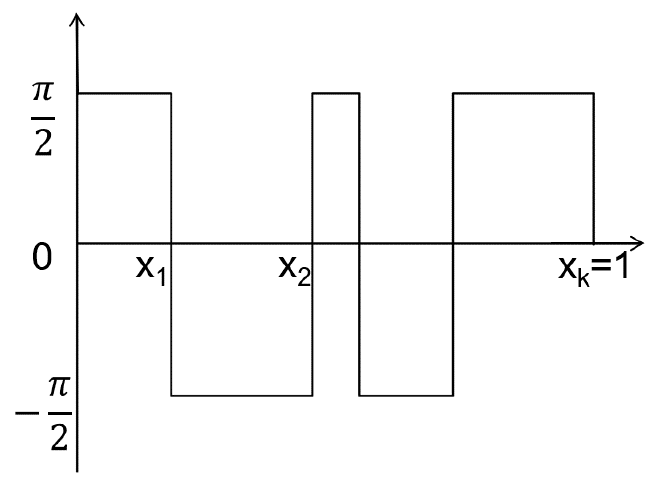
Figure 1. Transmittance distribution of a 1D DG.